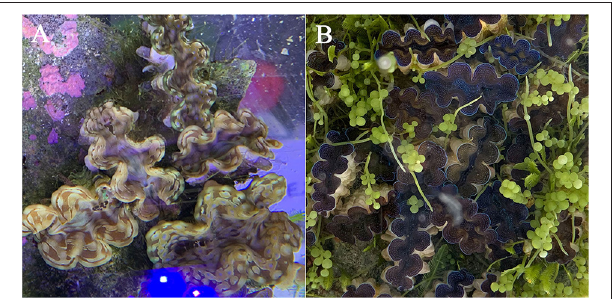
FIGURE 7 | Mantle color patterns of giant clam youth at day 360. (A) indicates BGY color of T. squamosa mantles with zooxanthellae in clades A–E; (B) indicates bule color of T. crocea mantles with zooxanthellae in clades A–E.